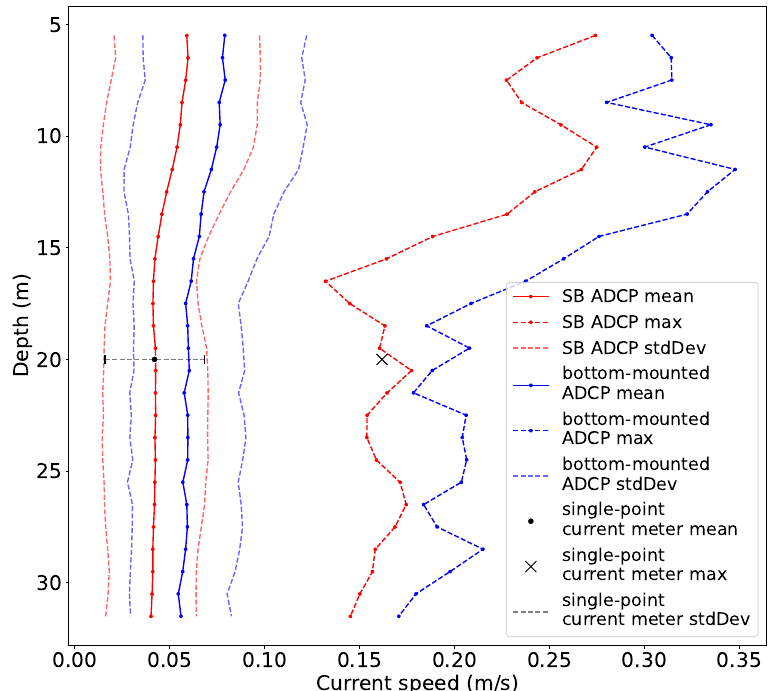
Figure 6. Time-averaged horizontal current speed and maximum speed over depth measured by the SB ADCP (blue), the bottom-mounted ADCP (red), and the single-point current meter (black) in Fusafjorden, October 2020. Standard deviations for the mean speed are displayed for